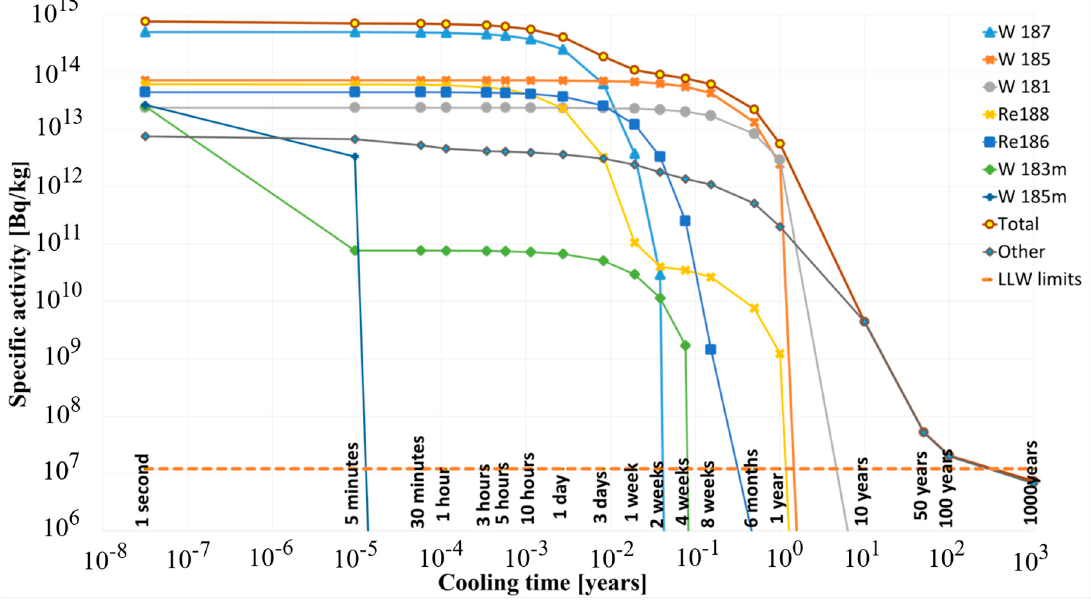
Figure 7. The specific activity of tungsten in the liner and reflector plates (WCLL concept).